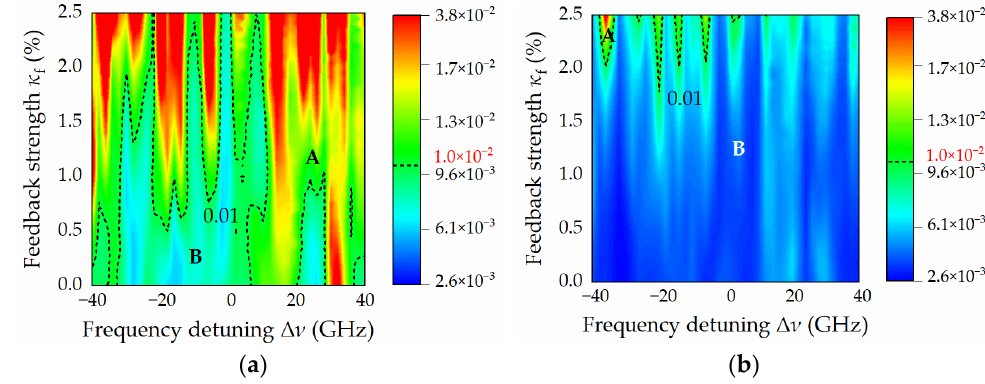
Figure 5. Two-dimensional maps of NMSEs in the parameter space of frequency detuning ∆ ν and feedback strength κ f for ( a ) κ inj = 0.4; ( b ) κ inj = 0.8, with I = 12 I th and M = 25; the dashed line indicates NMSE = 0.01.